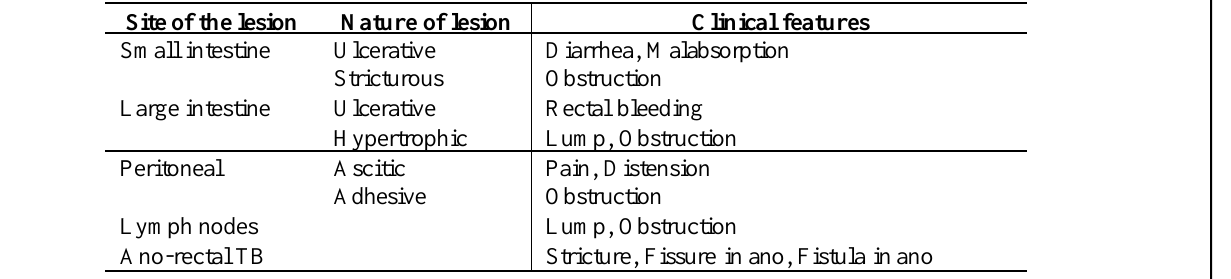
Table IV : Clinical features depending on site of tubercular